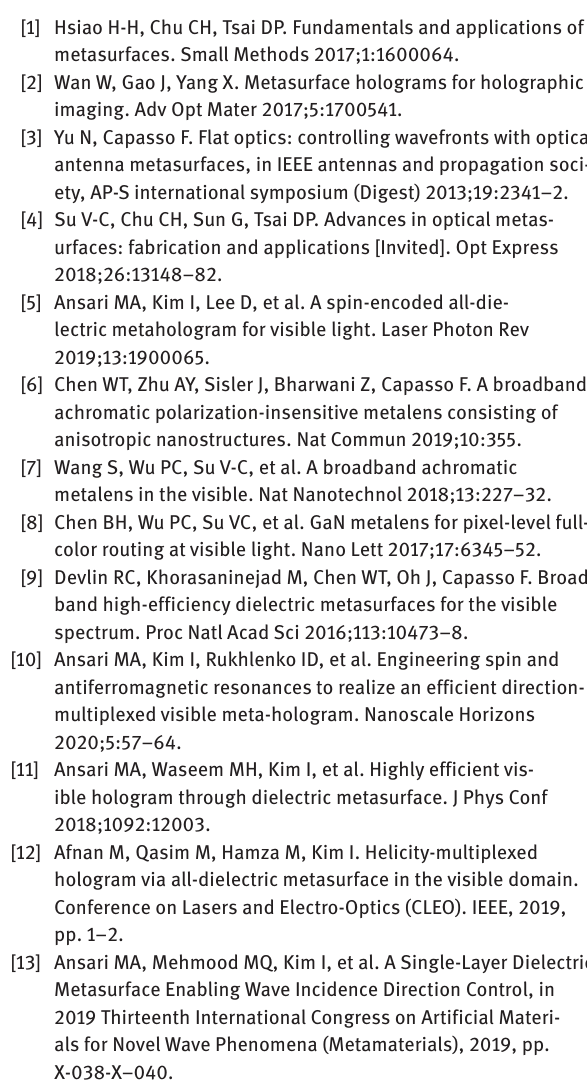
Figure 4A. The corresponding optical outputs under the unpolarised illumination of blue, green and red light are shown in Figure 4B–D,